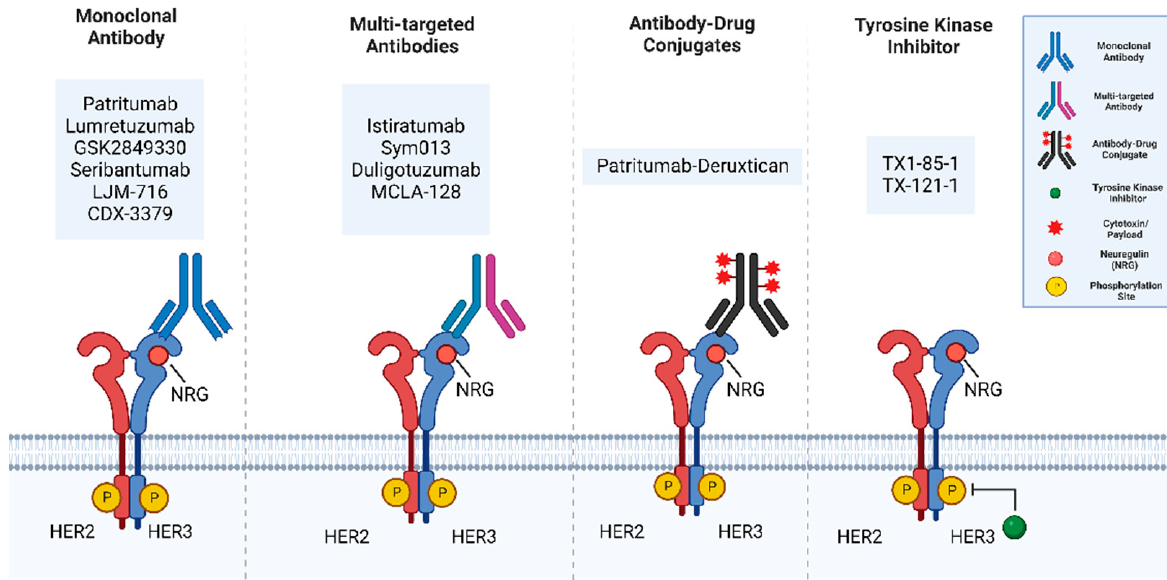
Figure 7. The main categories of HER3 targeting therapies include monoclonal antibodies, multi-targeted antibodies, antibody-drug conjugates, and tyrosine kinase inhibitors (TKIs). Monoclonal antibodies bind to the extracellular domain of HER3. Multi-targeted antibodies include bispecific antibodies which combine two different antigen-binding sites in a single antibody. Antibody-Drug Conjugates are monoclonal antibodies chemically linked to a chemotherapeutic drug. Tyrosine kinase inhibitors are small molecules inhibitors that block tyrosine kinase activity. Figure generated using BioRender. Table 1. Categories of HER3 targeting drugs and their mechanisms. Category Drug/Agent Targeting